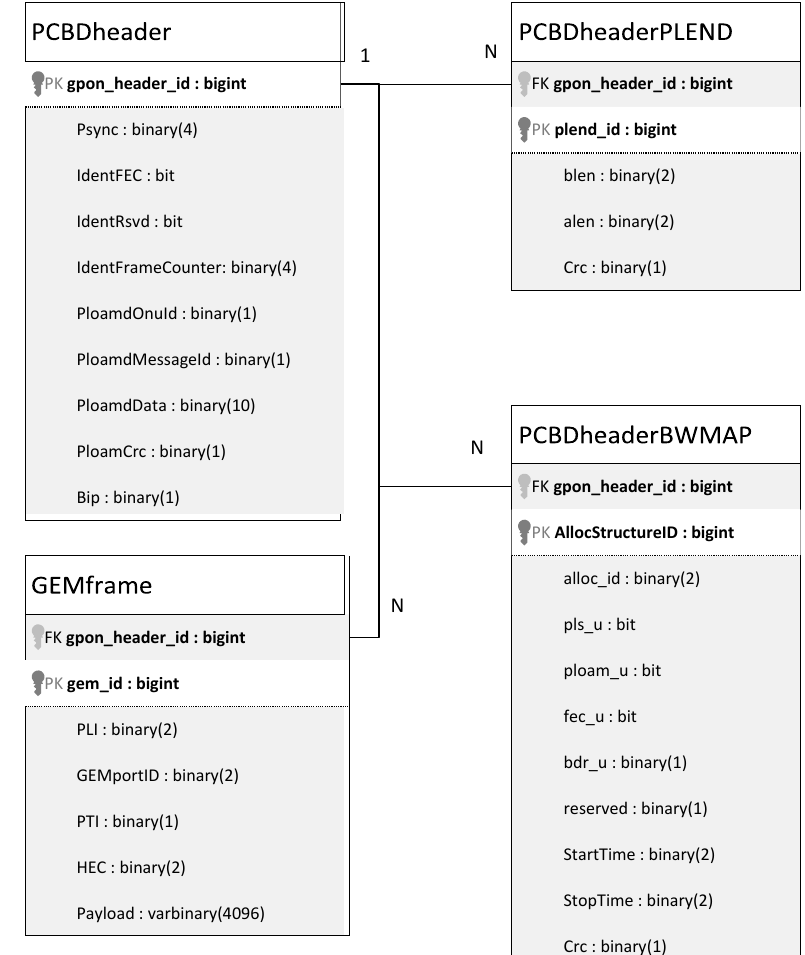
Figure 5. Database scheme for saving gigabit passive optical network (GPON)